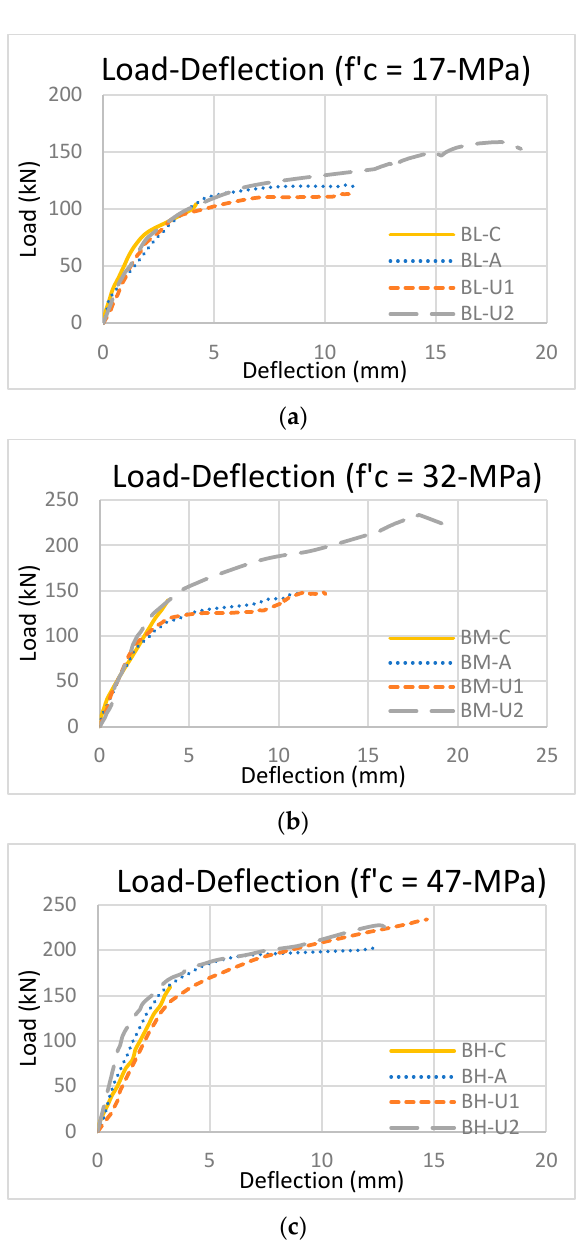
Figure 12. Experimental load ‐ deflection curves: ( a ) low strength concrete, ( b ) medium strength concrete, and ( c ) high strength concrete.